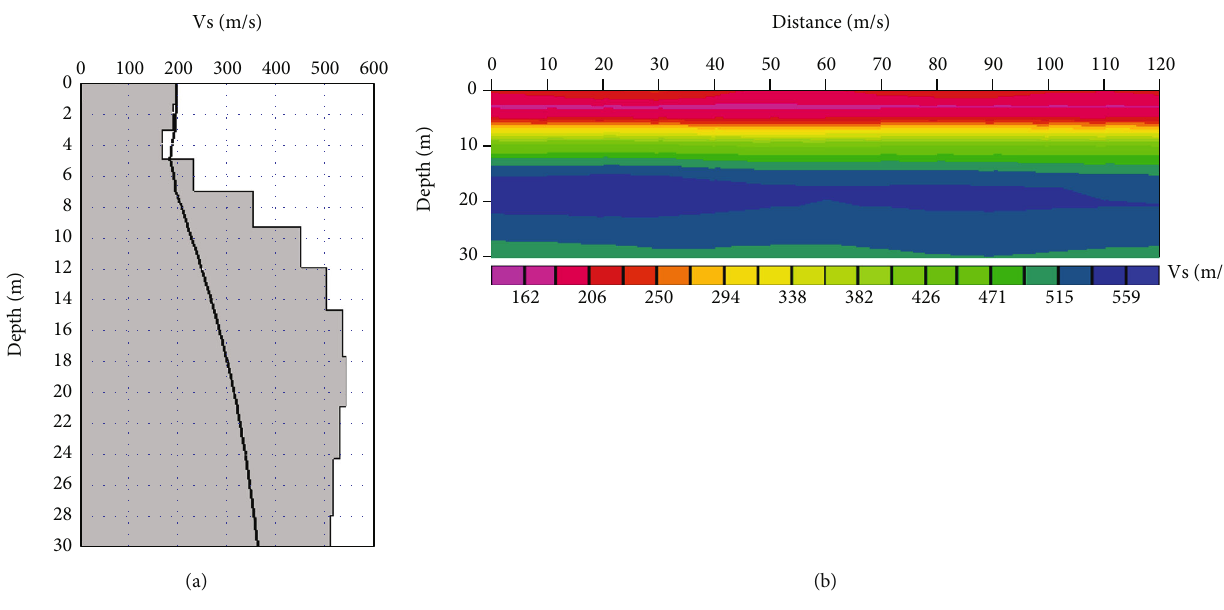
Figure 8: (a) MASW 1 1D pro fi le and (b) 2D Vs cross-section.